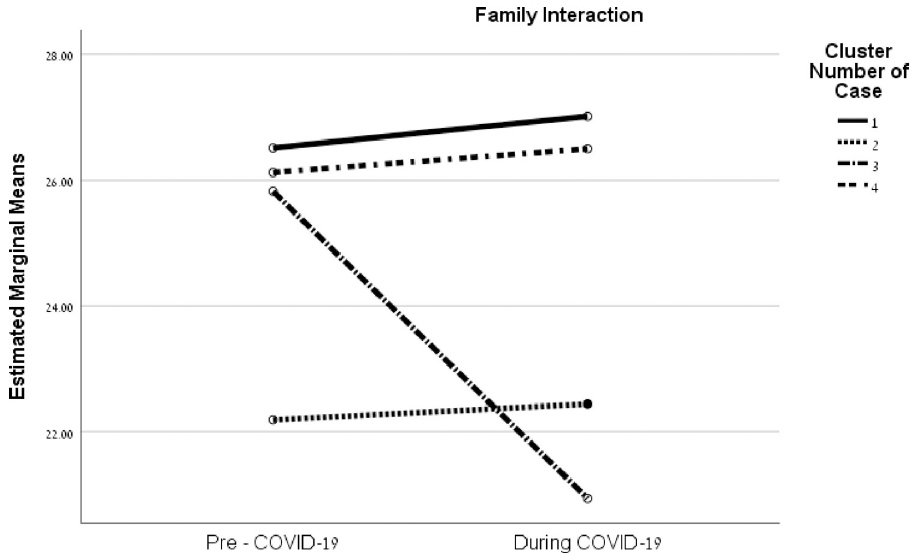
Fig 2. Interactions between coping strategies of families and before/during the COVID-19 crisis on family quality of life factors.